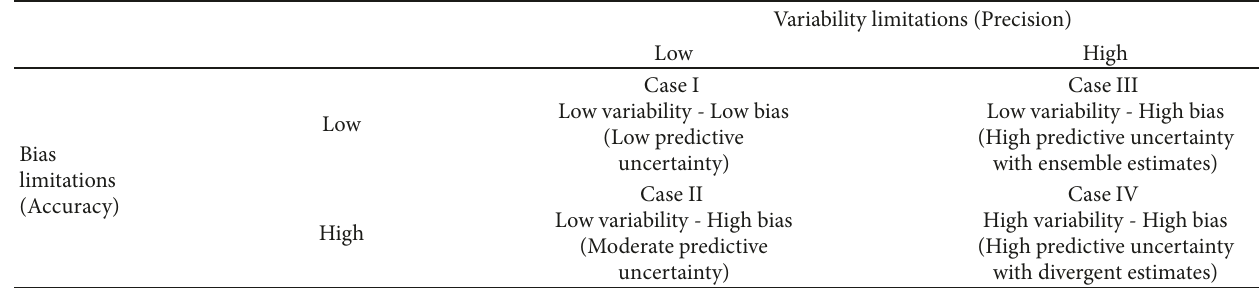
Table 1: This table showsthe classification of the four cases of uncertainties.